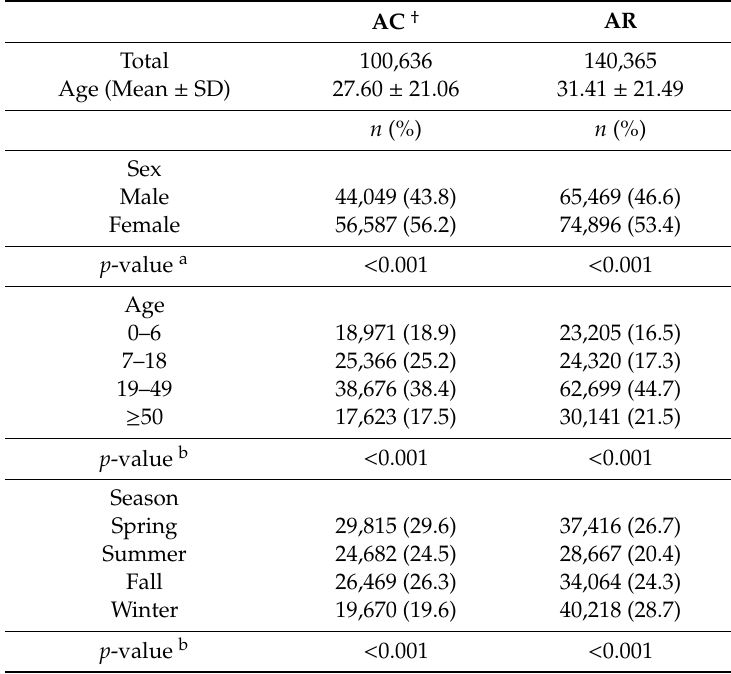
Table 1. Statistics of subjects having allergic conjunctivitis (AC) and allergic rhinitis (AR) by age, sex, and occurring between 2004 and